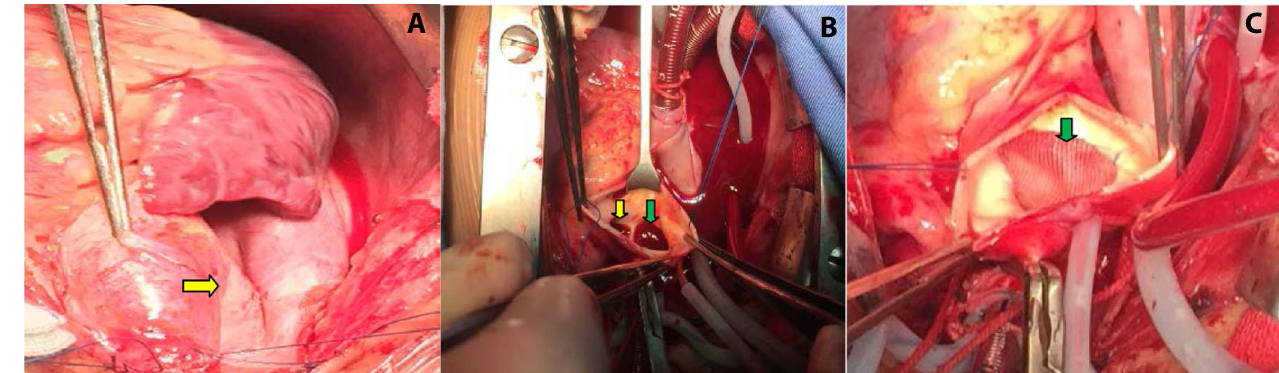
Fig. 2 – Surgical images showing polyester patch was used to separate the right pulmonary artery from communicating to the aorta and to correct the aortopulmonary septal defect. A) Yellow arrow points to the right pulmonary artery originating from the ascending aorta. B) Green arrow points to the right pulmonary artery opening; yellow arrow points to the defect between the ascending aorta and the pulmonary artery. C) Patch separates the right pulmonary artery opening from the aorta pulmonary through the